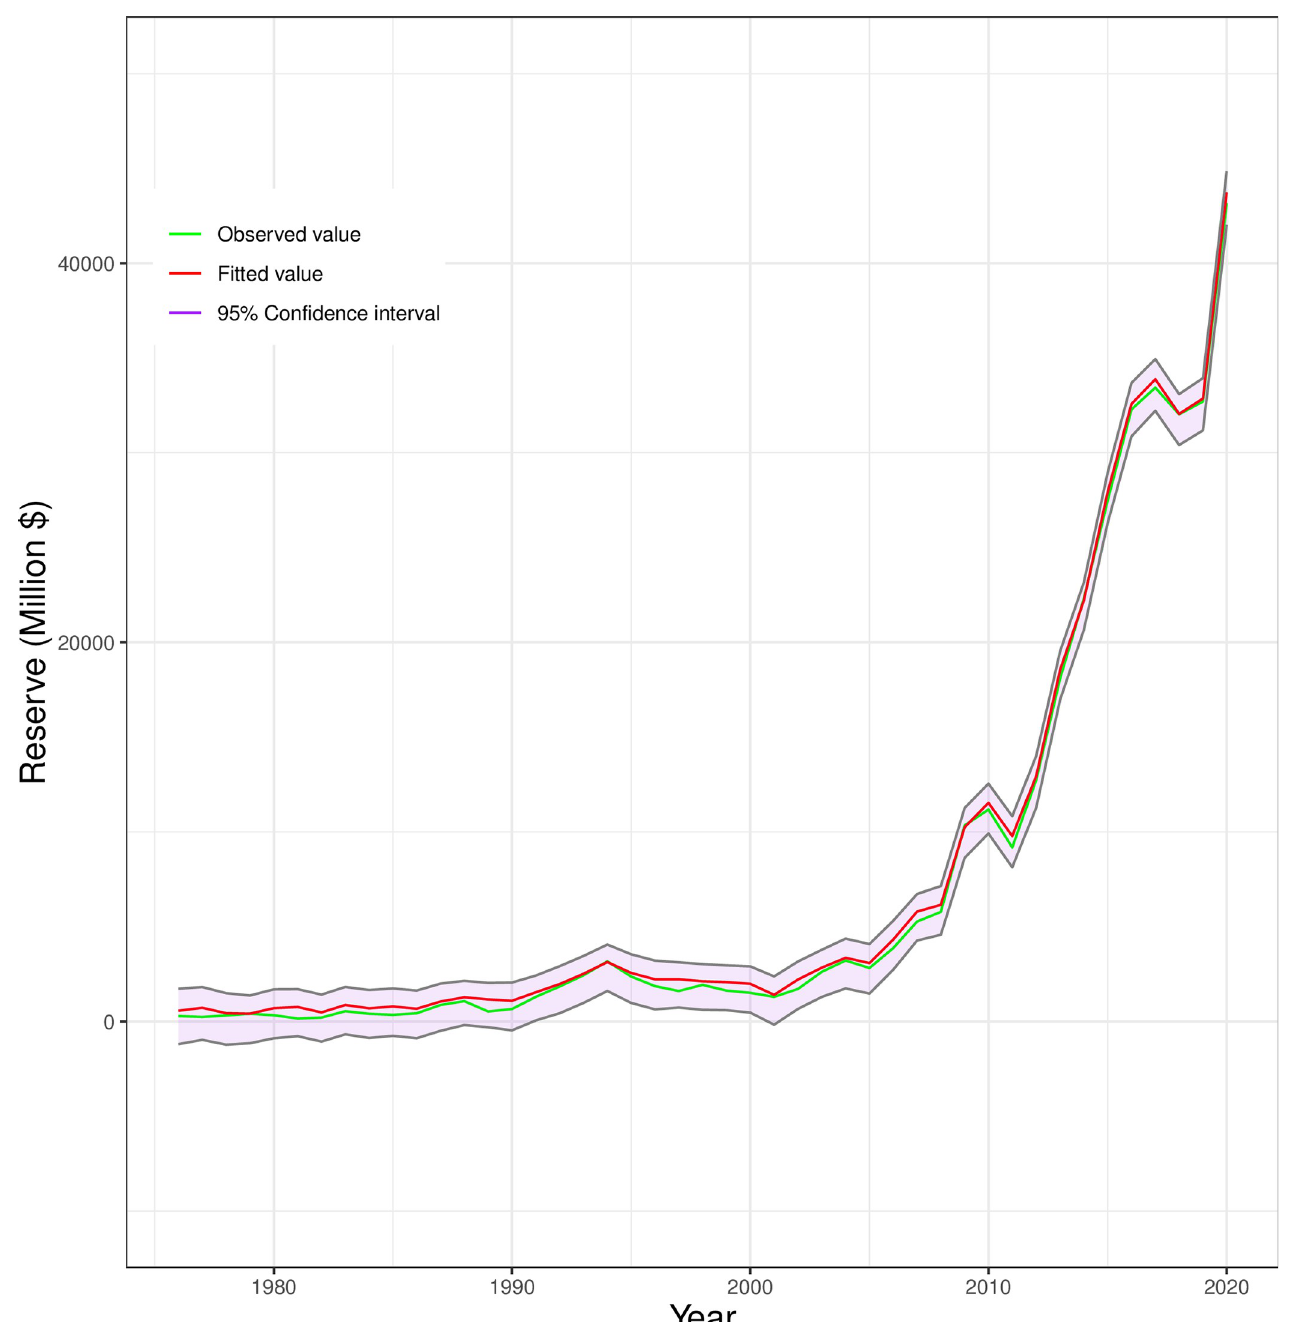
Fig 5. Comparison of predicted and observed total reserve in